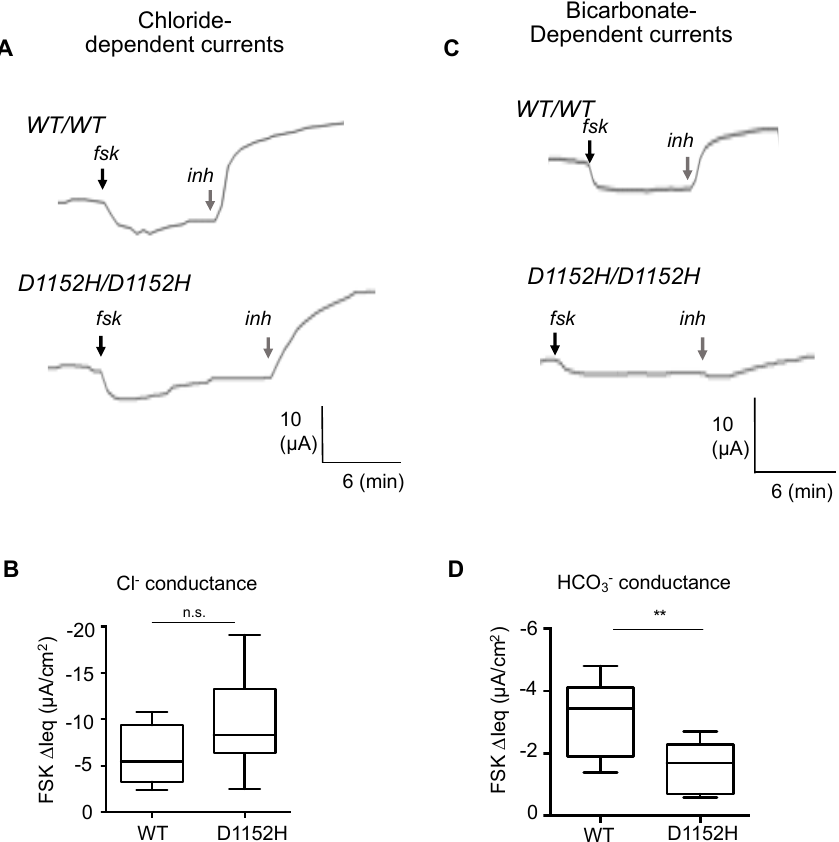
Figure 3. Nasal epithelial cultures derived from a patient homozygous for the D1152H mutation Bicarbonate-free bu ff er to study chloride conductance and ( C ) Chloride-free bu ff er to study bicarbonate conductance of the CFTR channel in nasal cell cultures from CF patient carrying D1152H / D1152H compared to a healthy control (WT / WT). ( B , D ) Bar graph showing mean ( ± SD) forskolin (10 µ M) activated ∆ Ieq for nasal cultures of healthy controls and D1152H / D1152H CF patient ( n = 6–9 replicates). (** p <